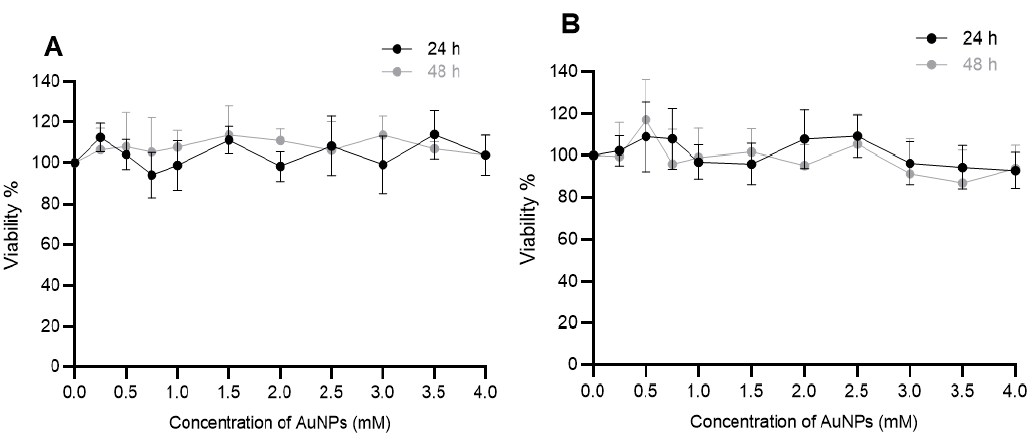
Figure 2. E ff ect of AuNPs on the viability of human cancer cells in vitro. ( A ) DU145 (prostate) and ( B ) A549 (lung) cancer cells were treated with AuNPs for either 24 and / or 48 h and cell viability (viability%) was determined using the MTS assay. Results expressed as the mean ± SEM of 3 replicates.